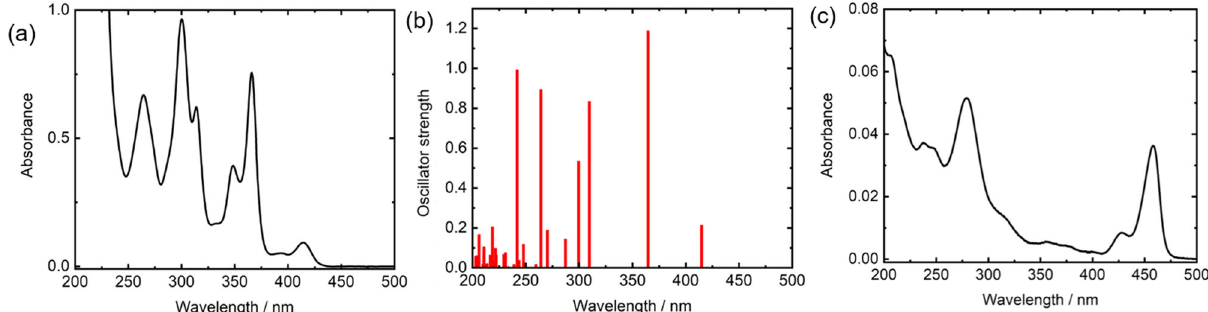
Fig. 2 Spectroscopy and TD-DFT calculation of C 9 -DNBDT-NW molecule and fi lm. a A transmission spectrum of the C 9 -DNBDT-NW/dichloromethane solution (100 μ M). b Calculated vertical transitions of a C 9 -DNBDT-NW molecule. c A transmission spectrum of the C 9 -DNBDT-NW fi lm on a